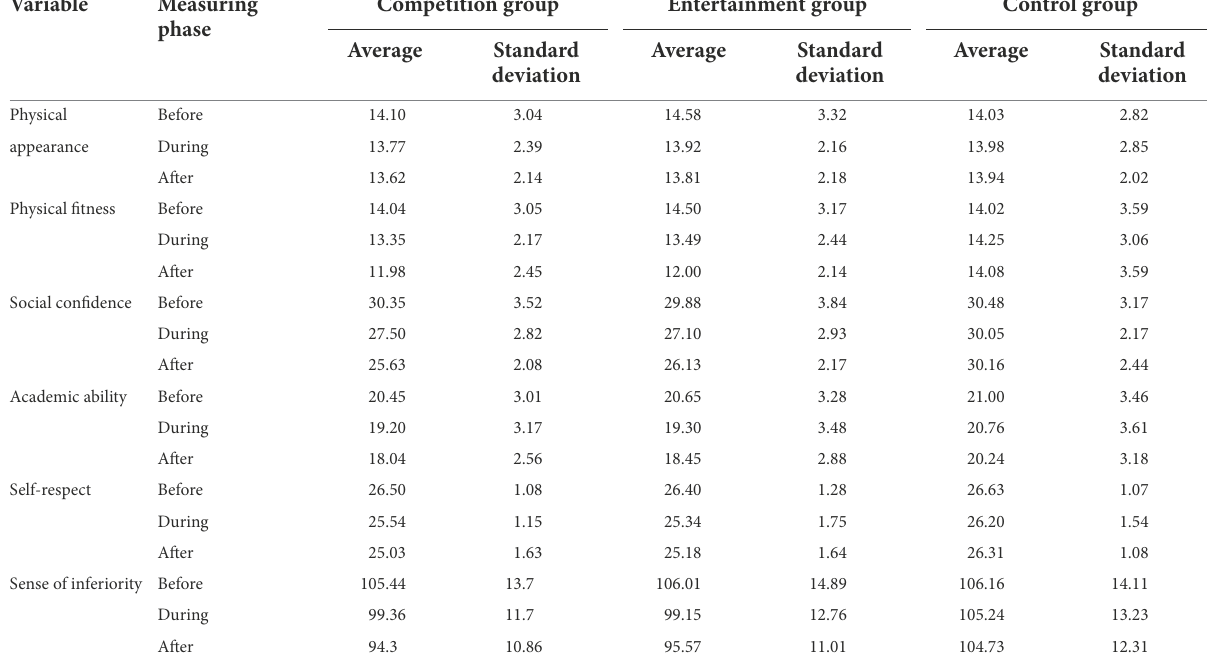
TABLE 5 Average and standard deviation of each variable in each